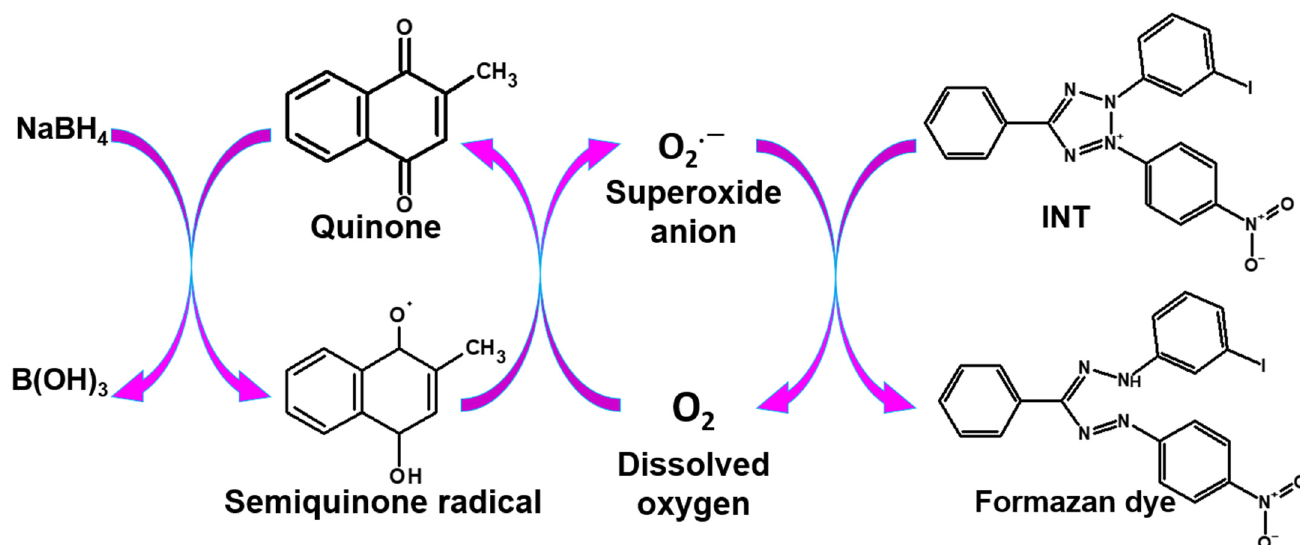
Scheme 2. Quinone redox cycle mechanism for colorimetric detection.